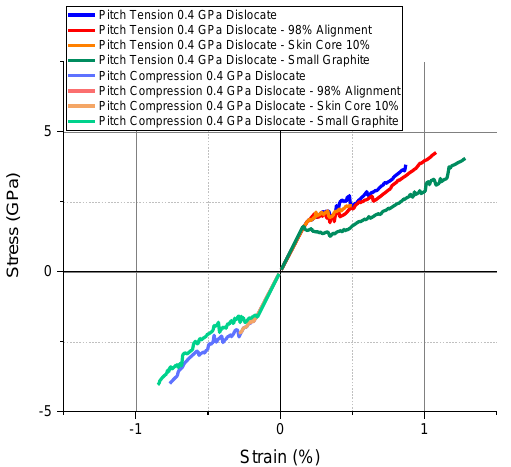
Figure 12. Tensile and compressive simulation results with microstructure modifications of alignment, skin-core alignment variations, and graphite size for PAN-based carbon fibers.